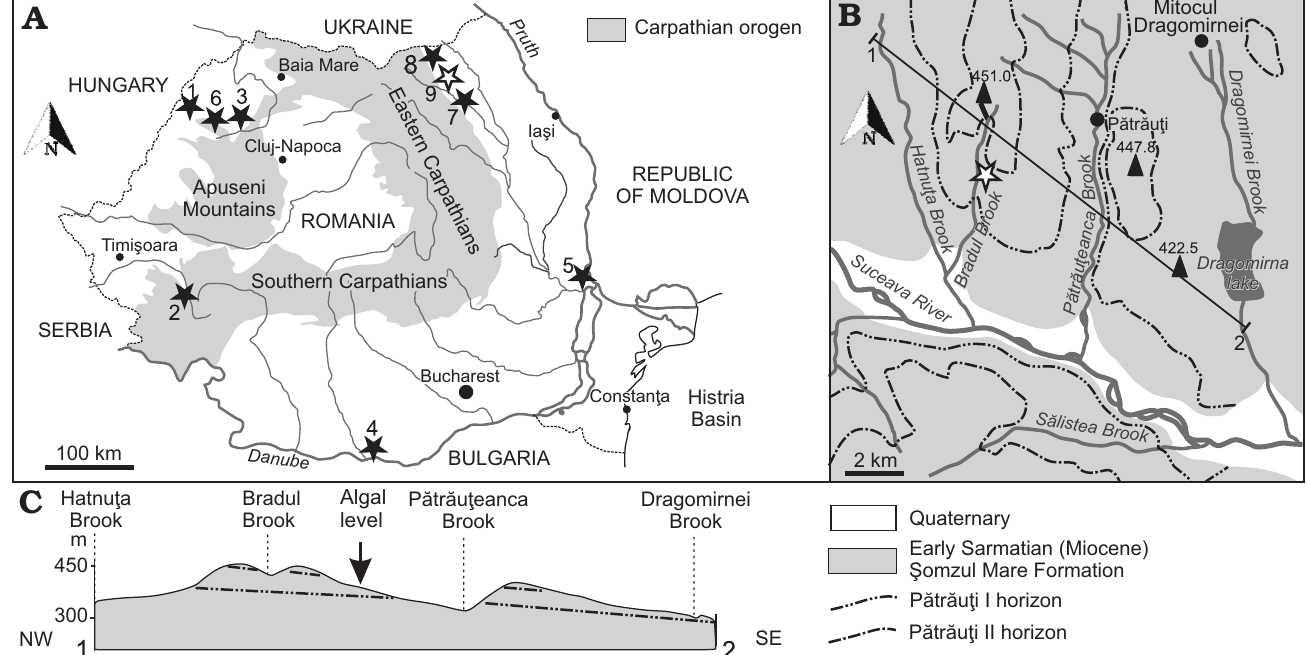
Fig. 2. A . Location of the Sarmatian dasycladalean outcrops in Romania (black stars, white star indicates Acetabularia moldavica type locality). 1, Satu Nou (Bihor County); 2, Soceni (Cara ş -Severin County); 3, Cop ă cel and Chijic (Bihor County); 4, Izlaz (Olt County); 5, Frumu ş i ţ a (Gala ţ i County); 6, Lunc ş oara (Bihor County); 7, R ă d ăş eni (Suceava County); 8, Iaz (Suceava County); 9, P ă tr ă u ţ i (Suceava County). B . Geological map of the environs of P ă tr ă u ţ i with the site of Acetabularia moldavica sp. nov. C . Profile of the P ă tr ă u ţ i outcrop.